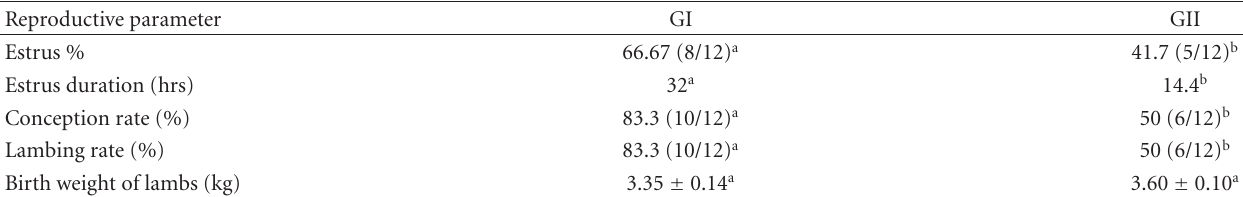
Birth weight of lambs (kg)